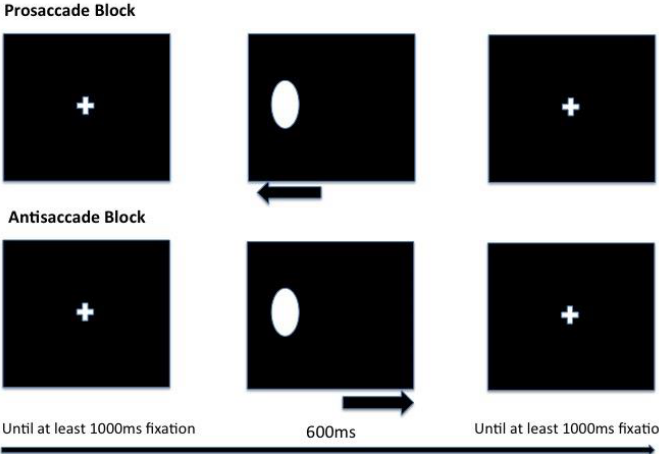
Figure 1. Presentation order of trials in pro- and antisaccade blocks with timings.